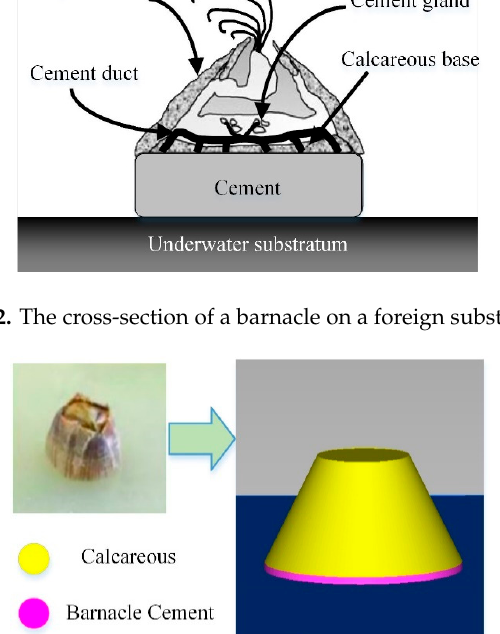
Figure 3. The cross-section of a barnacle on a foreign substratum.